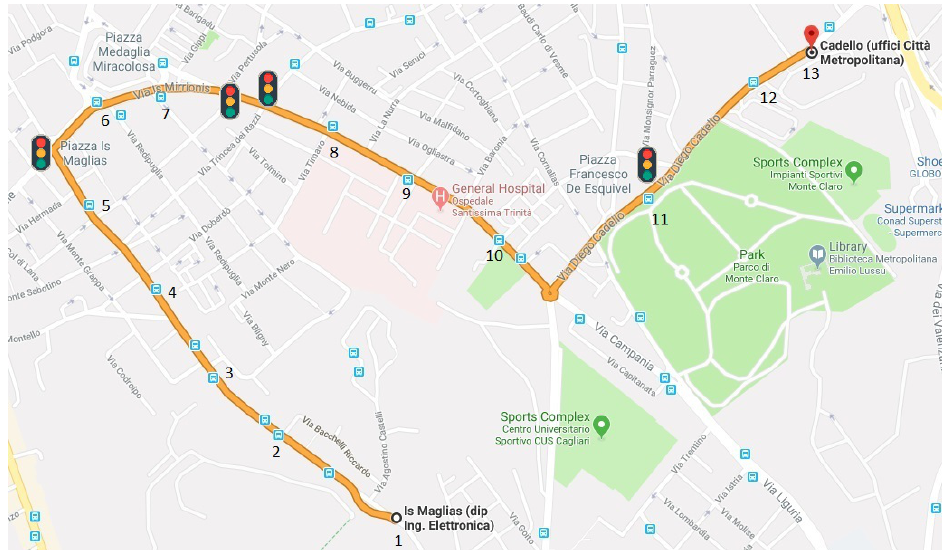
Figure 7. Path of the vehicle for the experiments. Table 5. Origin and Destination